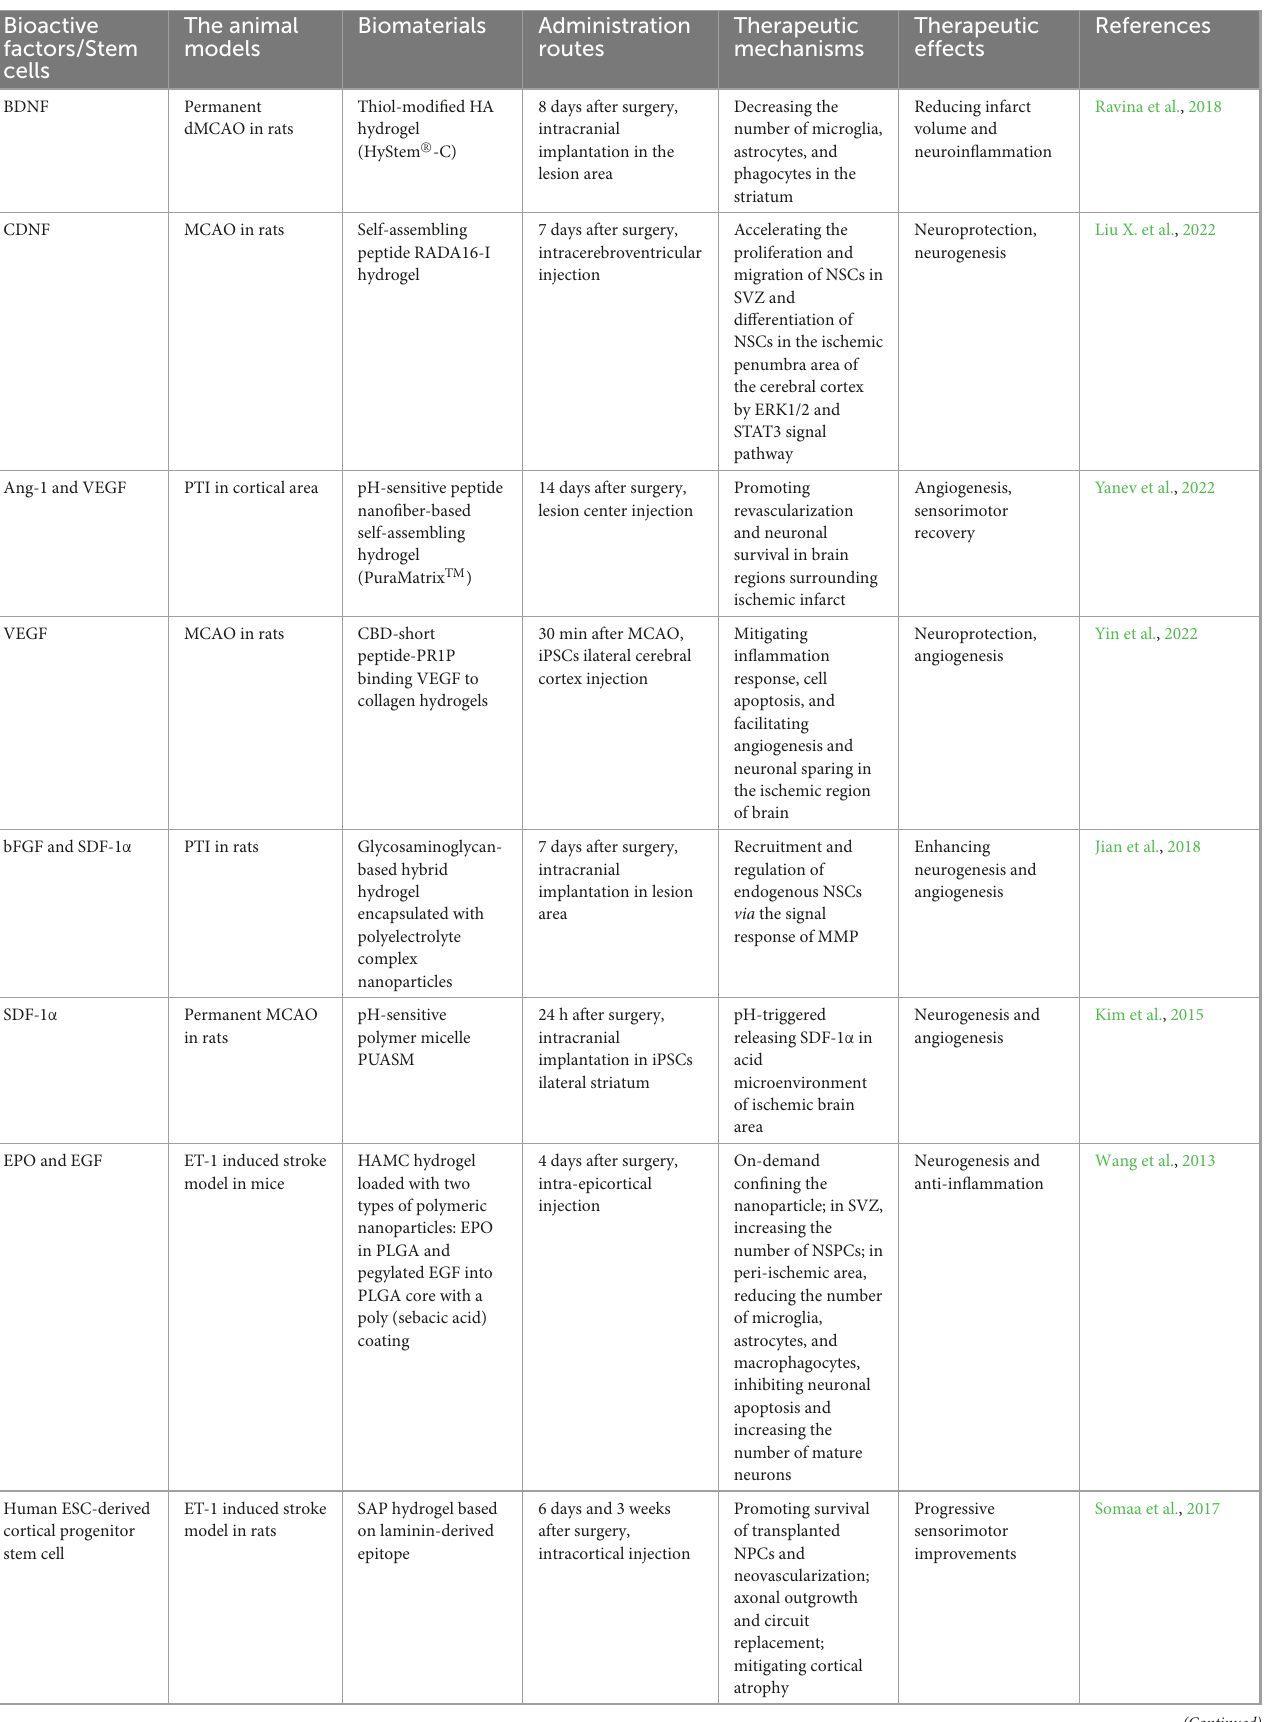
TABLE 2 Summary of common bioactive factors and stem cells delivered by biomaterials in the treatment of IS. Bioactive